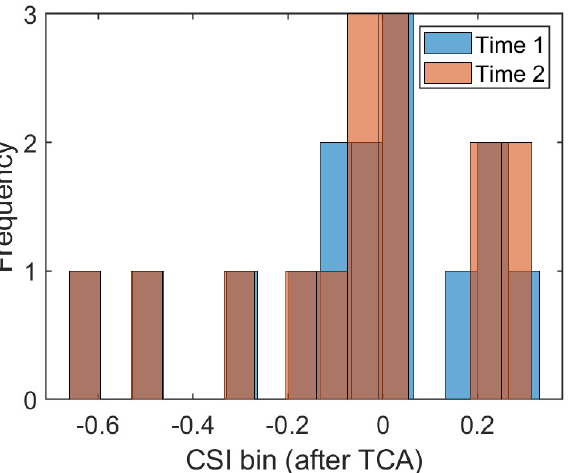
Figure 5. Frequency histogram after transfer component analysis (TCA) transformation at position #1 (m =